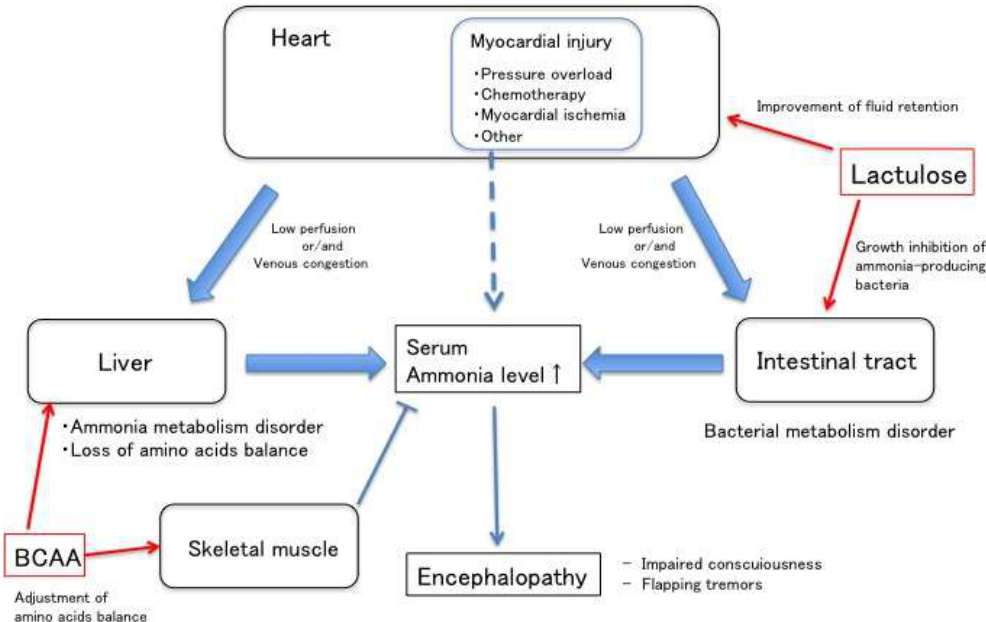
Figure 6. Hyperammonemia pathway in heart failure (red arrows; effective points of drugs).